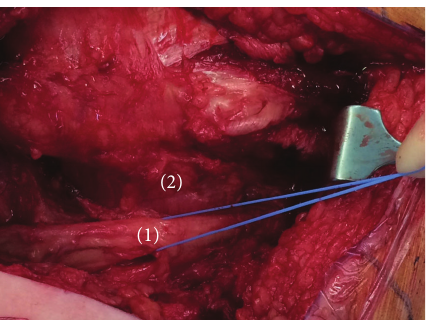
Figure 5: Intraoperative image after resection of the short external rotators of the right hip. (1) Decompressed sciatic nerve. (2) Area previously occupied by short external rotators of the right